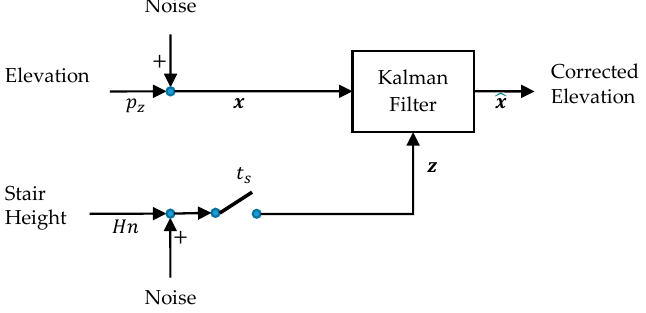
Figure 4. A Kalman filter makes foot elevation corrections using the known step height (riser), during each stationary time t s .